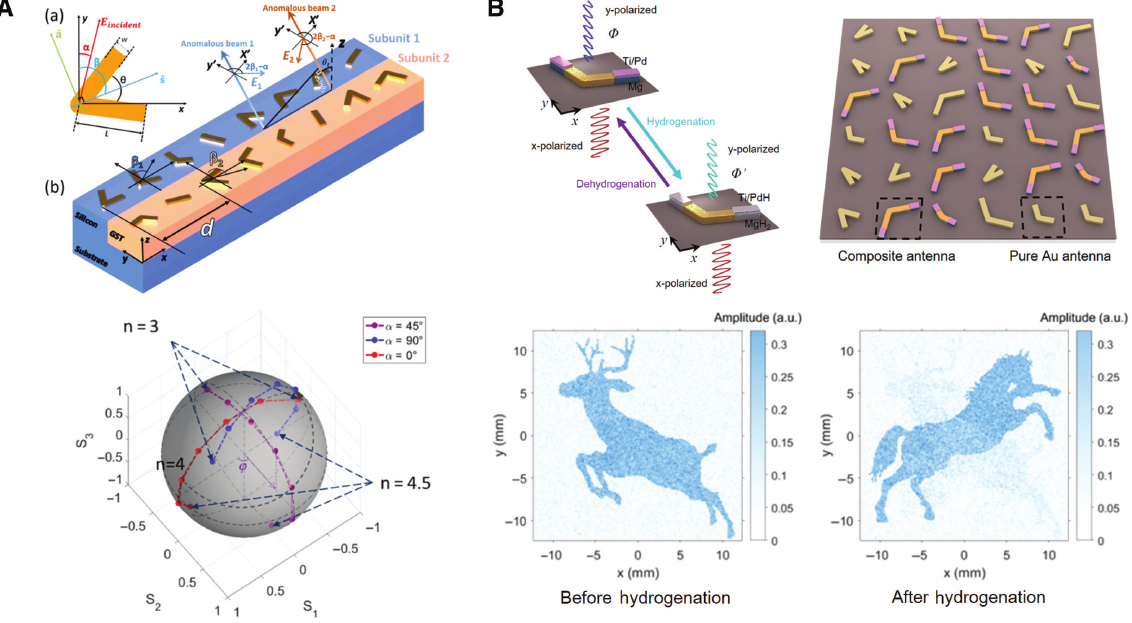
Figure 4: Dynamically tunable metasurfaces. (A) Schematic of the metasurface for active tunability of the ellipticity of anomalously diffracted beams [108]. (B) Schematic diagram and simulation results of the addressable dynamic metasurface holographic display method based on pure gold V-shaped antennas and composite gold/Mg V-shaped antennas